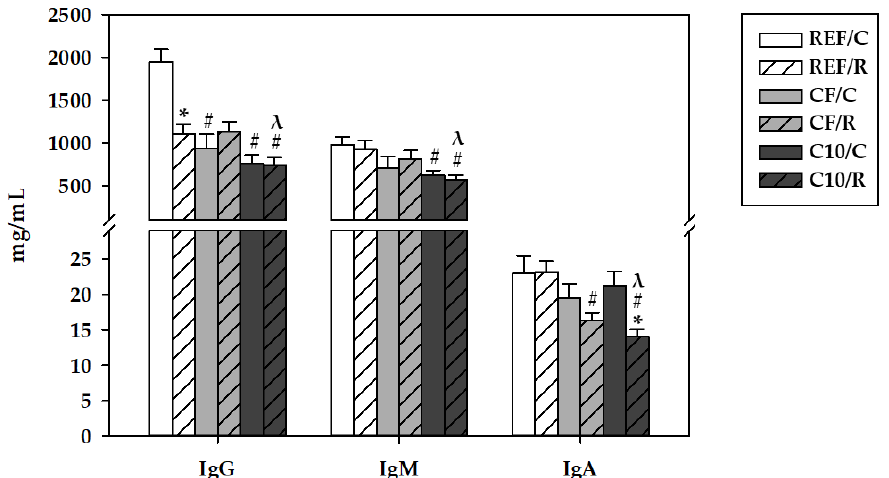
Figure 6. Serum concentrations of IgG, IgM and IgA 16 h after performing the final exhaustion test. REF, reference diet; CF, 5% cocoa fiber-enriched diet; C10, 10% cocoa-enriched diet. The control (C) groups are represented by smooth bars, and the runner (R) groups are represented by striped bars. Data are expressed as mean ± SEM (n = 8). Statistical differences (a Kruskal–Wallis test followed by a Mann–Whitney U test): * p < 0.05 vs. the C group in the same diet; # p < 0.05 vs. the same exercise condition in the REF diet; λ p < 0.05 vs. the same exercise condition in the CF